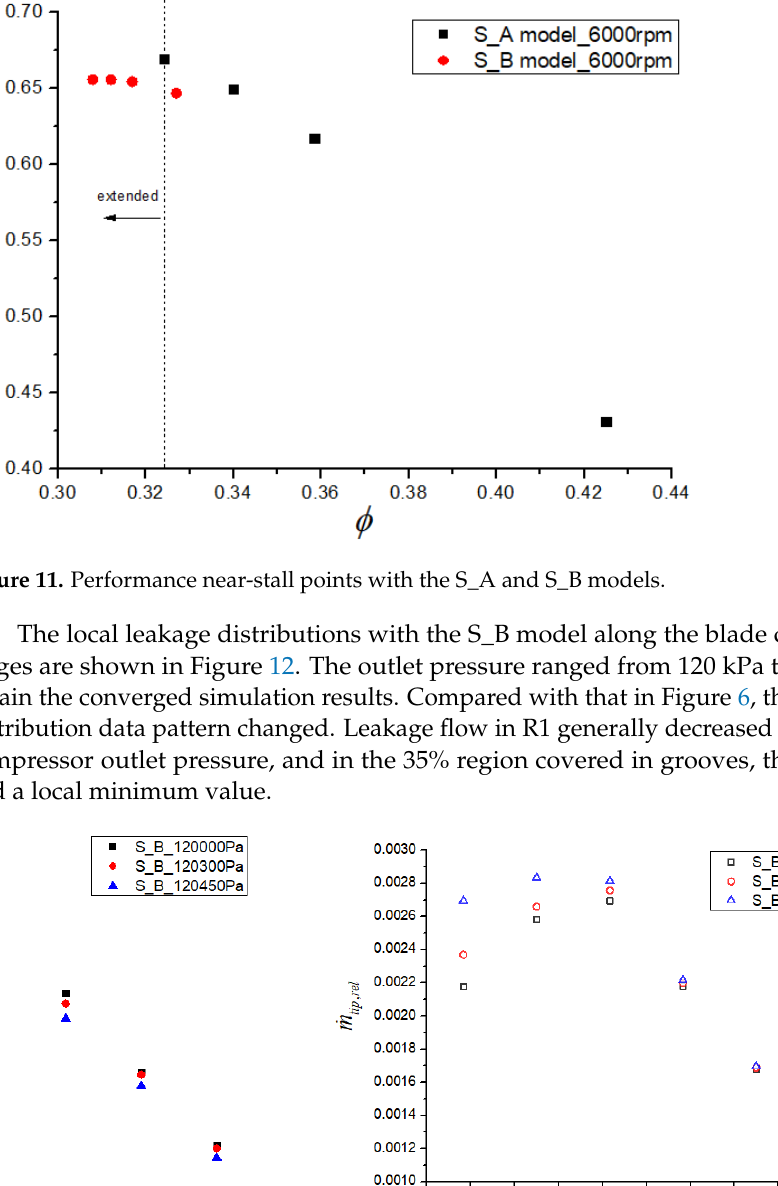
Figure 10. Stability enhancement effects of the different CT models.